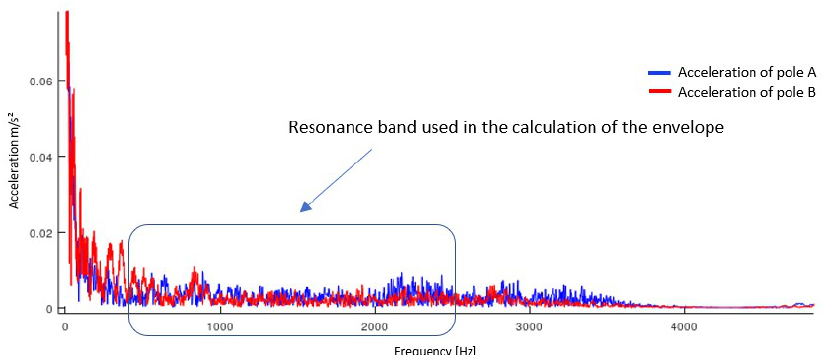
Figure 10. Spectrum of acceleration signals at the moment of the maneuver, highlighting the reso- nance band.